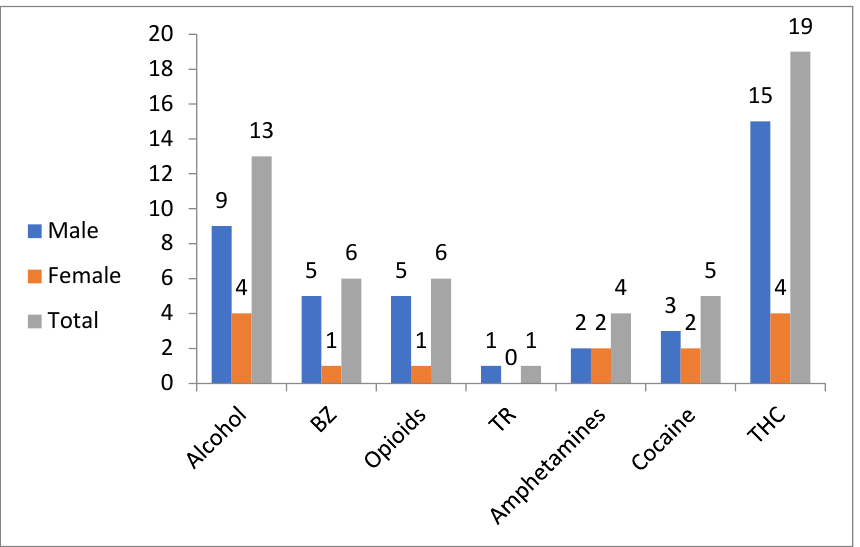
Figure 2. Substance detections among French adolescents (n = 65; 45 males and 20 females) in Lille during 2017 – 2018. BZ: benzodiazepines; TR: tramadol; THC: tetrahydrocannabinol.